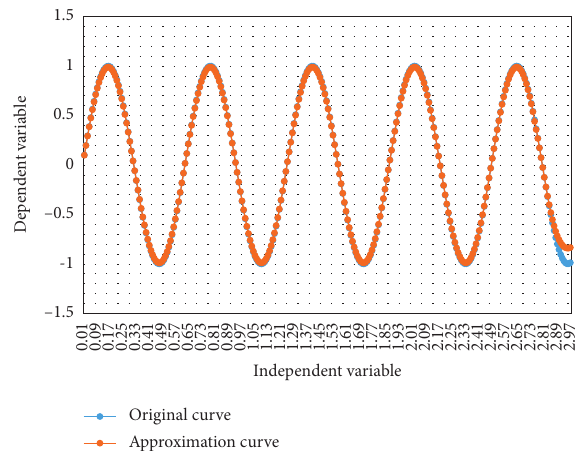
Figure 6: Optimized function approximation effect diagram.